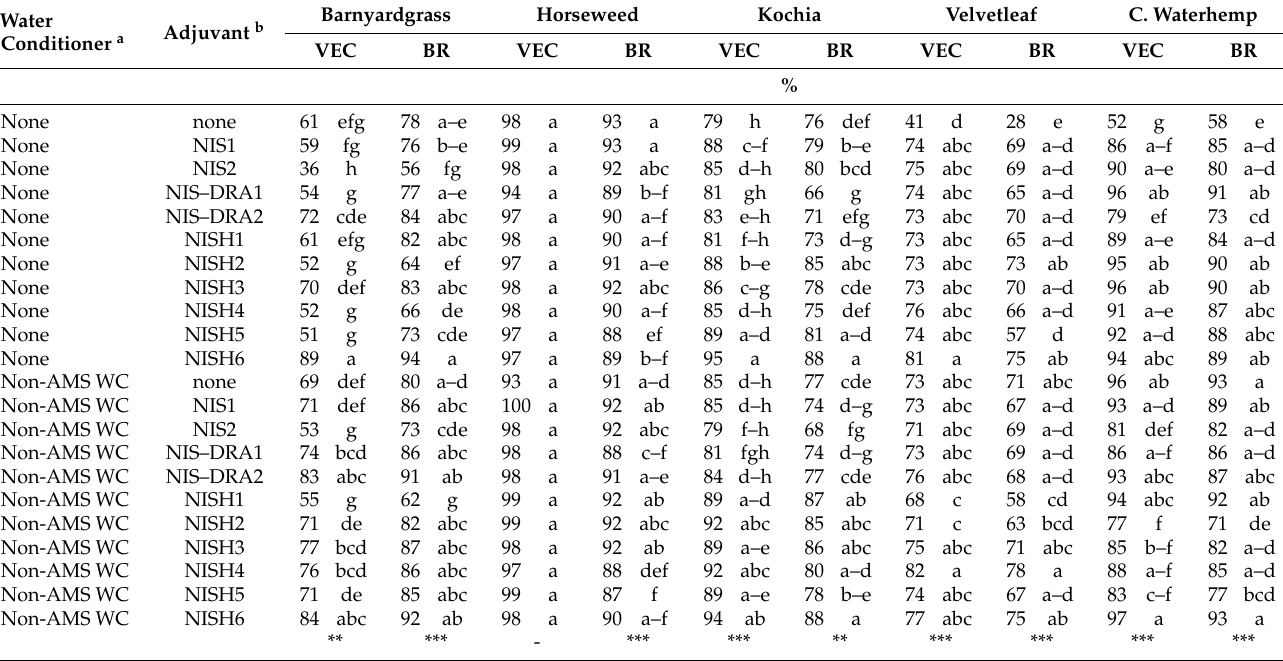
Table 9. Biomass reduction (BR) and visual estimation of control (VEC) of barnyardgrass, horseweed, kochia, velvetleaf, and c. waterhemp at 28 days after application (28 DAA) for dicamba plus glyphosate solutions at 279 and 385 g ae ha − 1 , respectively, with no water conditioner and with non-AMS water conditioner alone or tank mixed with 10 adjuvants in greenhouse